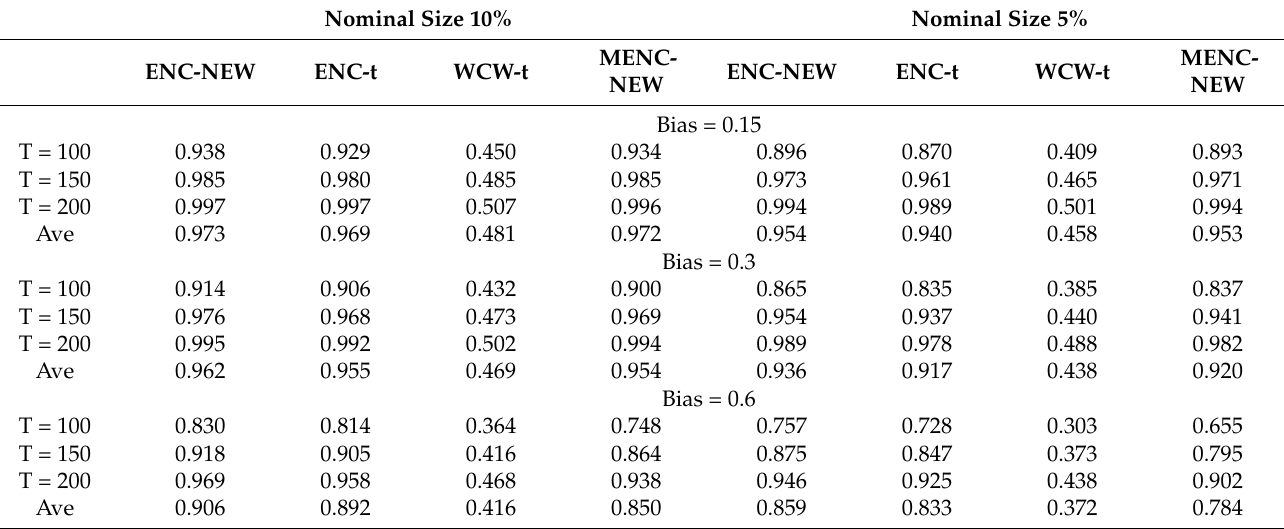
Table 9. Raw power with nominal sizes 10% and 5%, and P/R =